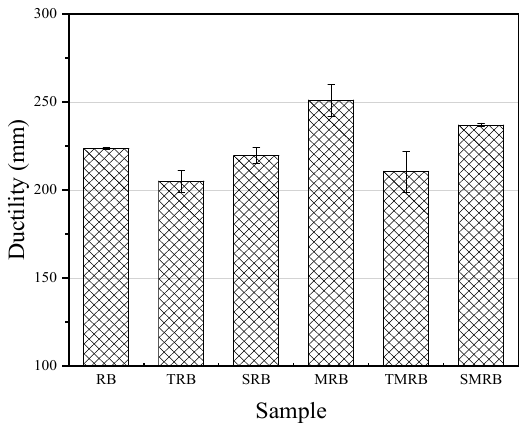
Figure 7. Ductility of rubberized bitumen.